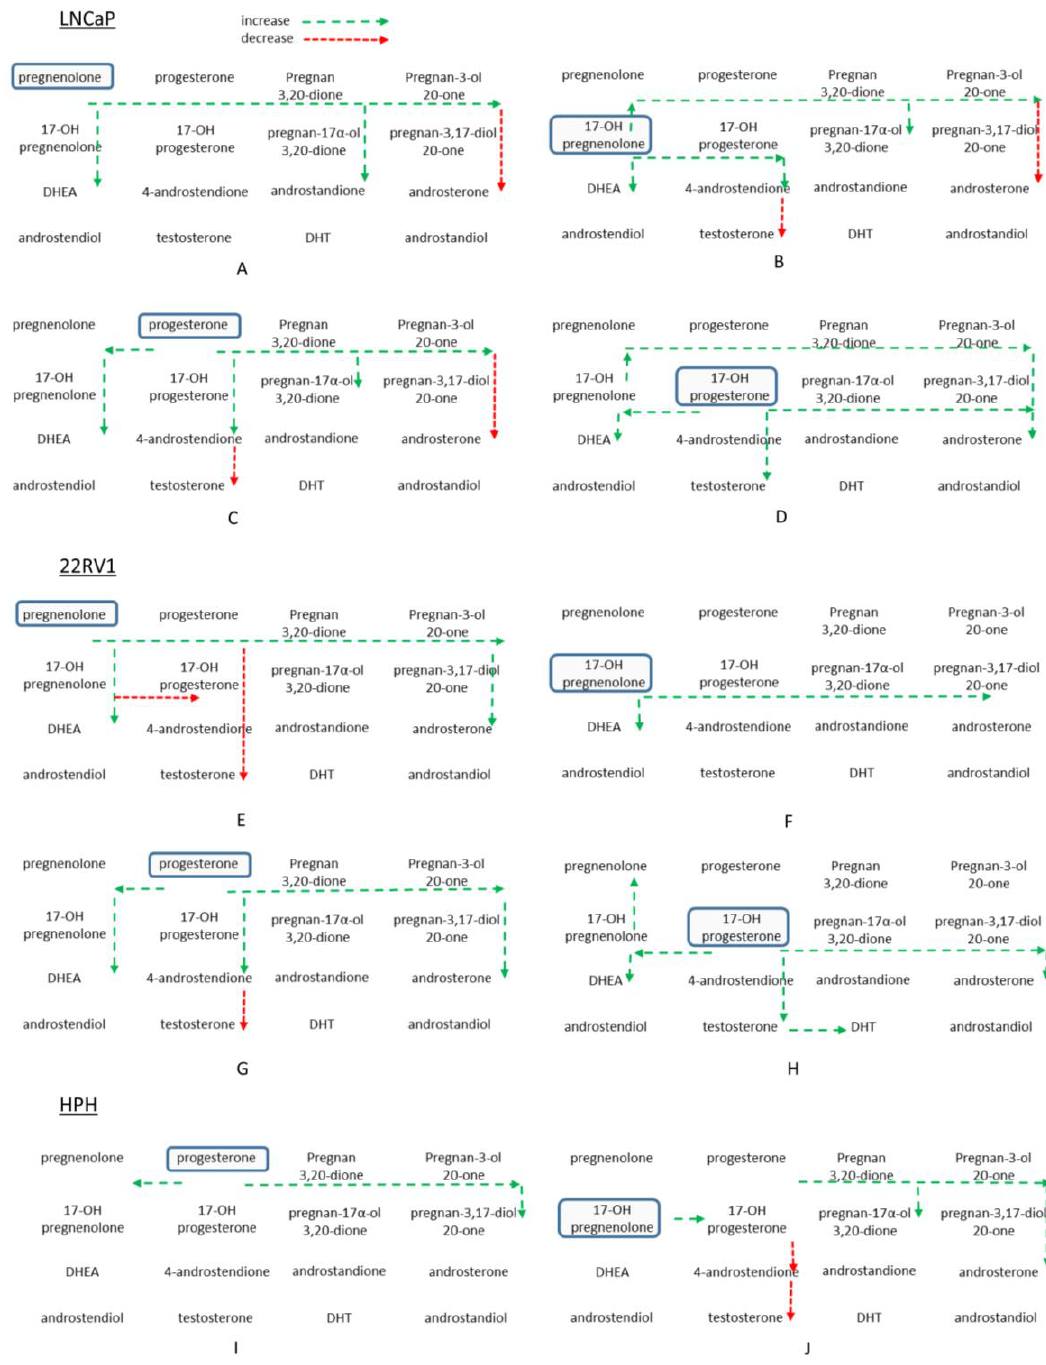
Figure 4. Overview of the relative changes in androgen pathway steroids in vitro following incubation with four different precursors. Panels A – D are from LNCaP cell pellet extracts after treatment with 2 µ g/mL pregnenolone, 17-OH-pregnenolone, progesterone, and 17-OH-progesterone, respectively, for 48 h. Panels E – H are from 22Rv1 cell pellets with the same treatment and order as for LNCaP cells above. Panels I and J highlight incubations of 2 µ g/mL progesterone and 17-OH-pregnenolone with human prostate homogenate for 60 min. Long dashed green arrows indicate increase, short dashed red arrows indicate decrease.